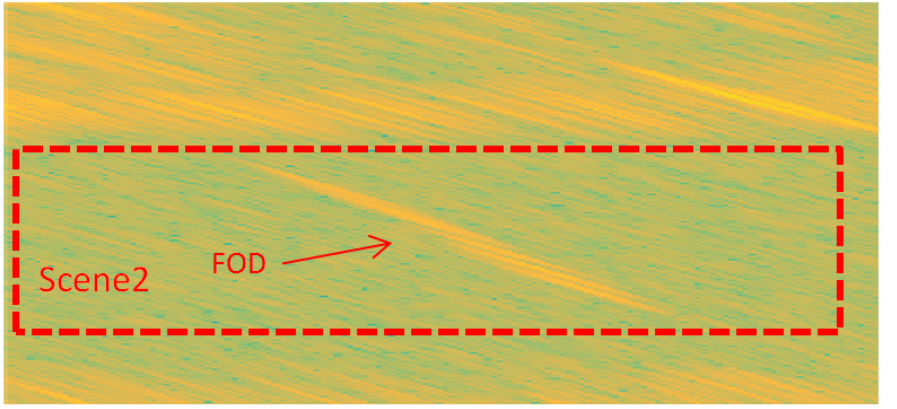
Figure 13. FOD target deployment, Scene 2.